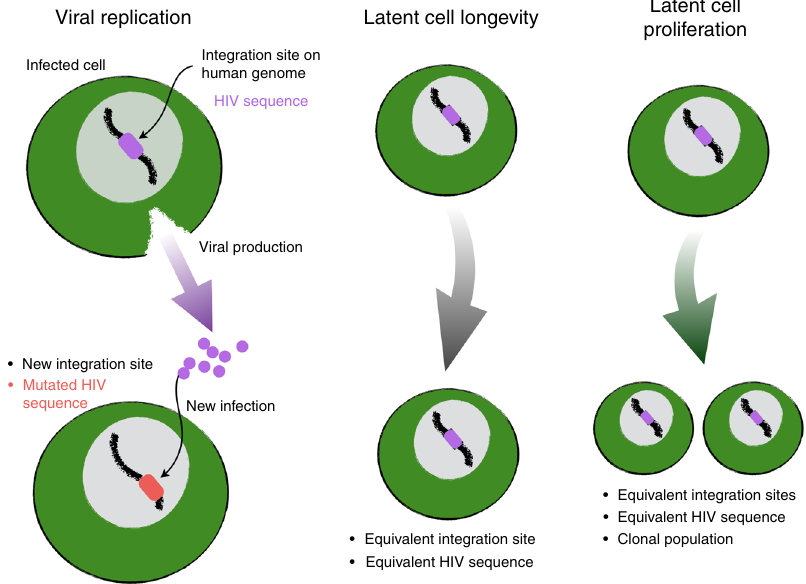
Fig. 1 Genetic signatures of HIV persistence during ART. Viral replication despite antiretroviral therapy (ART) would lead to accrual of new mutations (HIV sequence color change) and novel chromosomal integration sites in newly infected cells. Longevity of latently infected cells maintains sequences and integration sites. Cellular proliferation of latently infected cells produces clonal populations carrying identical HIV sequences in identical integration